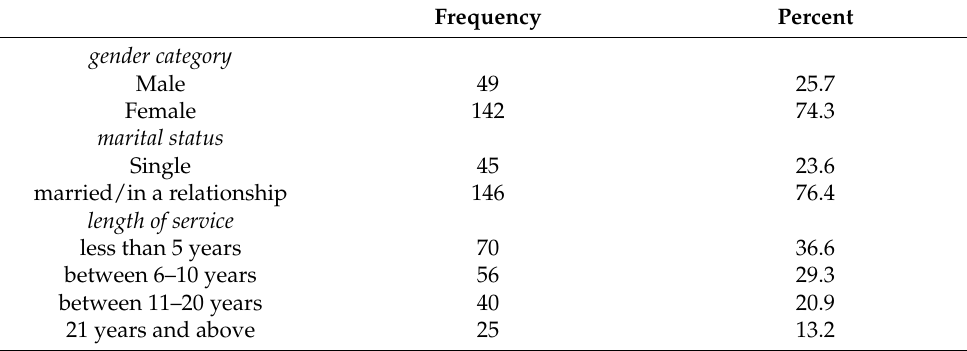
Table 1. The demographic profile of respondents (N = 191).